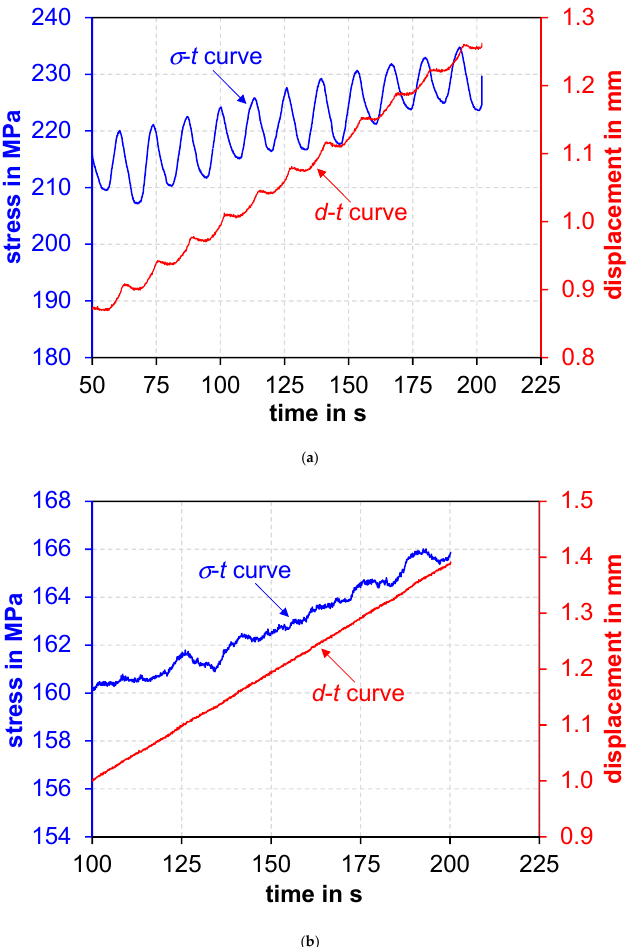
Figure 3. Typical stress and displacement versus time curves of ( a ) AA6061 and ( b ) Mg-ME20 alloy under a strain control mode, obtained after position and load (P + L) auto-tuning.